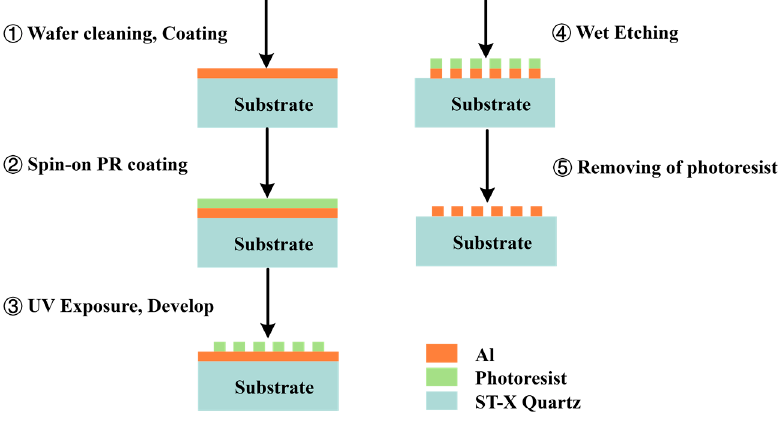
Figure 11. Fabrication process of SAWR’s electrodes .